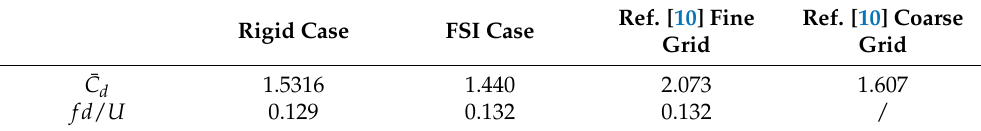
Table 1. Drag coefficients and Strouhal number from different